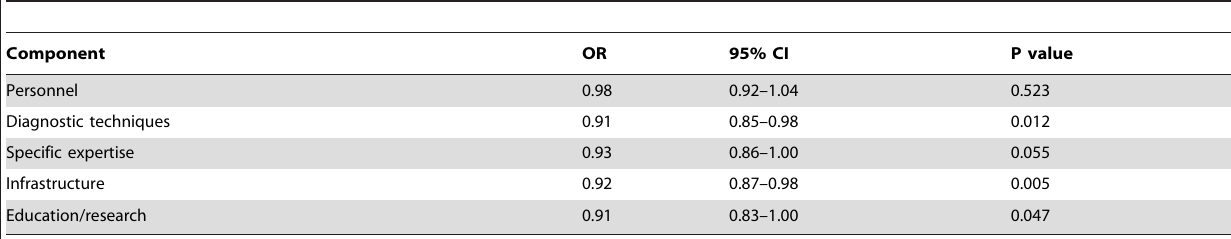
Table 8. The impact of subcategory CSC score on in-hospital mortality after intracerebral hemorrhage adjusted by age, sex and JCS.